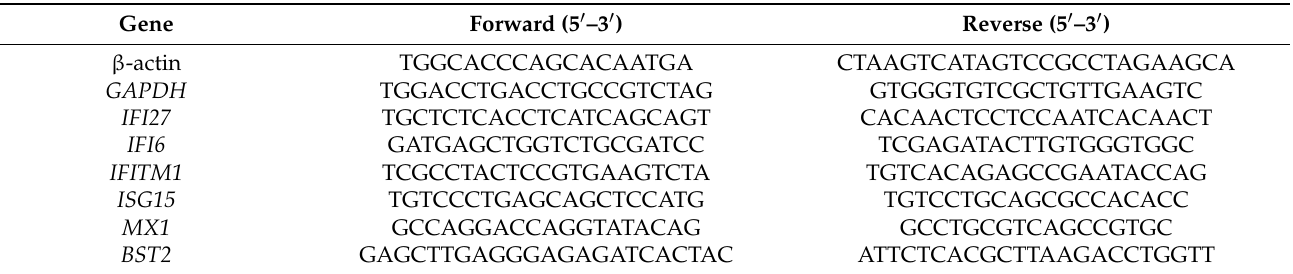
Table 3. Sequences of primers used for quantitative reverse transcription-polymerase chain reaction